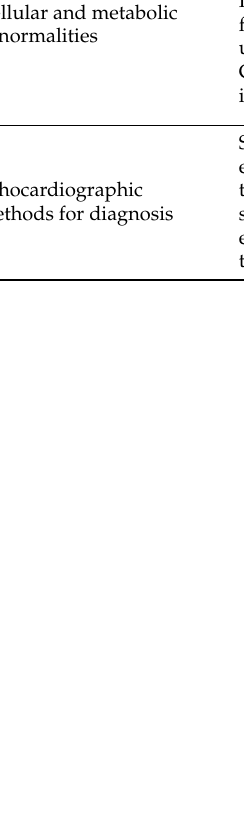
Table 2. Novel biomarkers for diagnosing diabetic cardiomyopathy. Promising